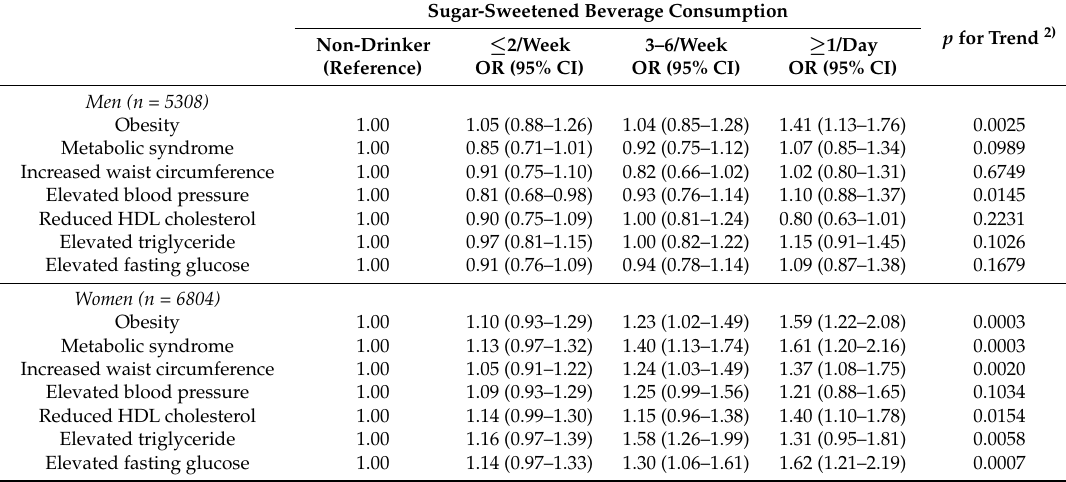
Table 4. Multivariate adjusted odds ratios 1) and 95% CI for obesity and metabolic syndrome (including its individual components) according to sugar-sweetened beverage